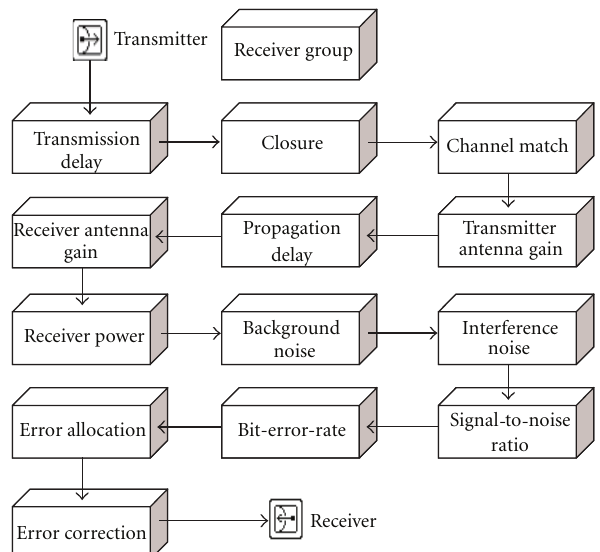
Figure 3: OPNET radio transceiver pipeline stages.